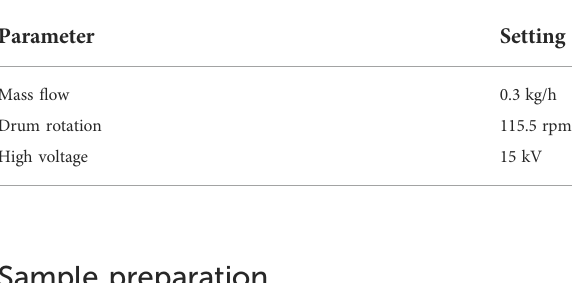
TABLE 1 Optimized parameter settings for electrostatic separation